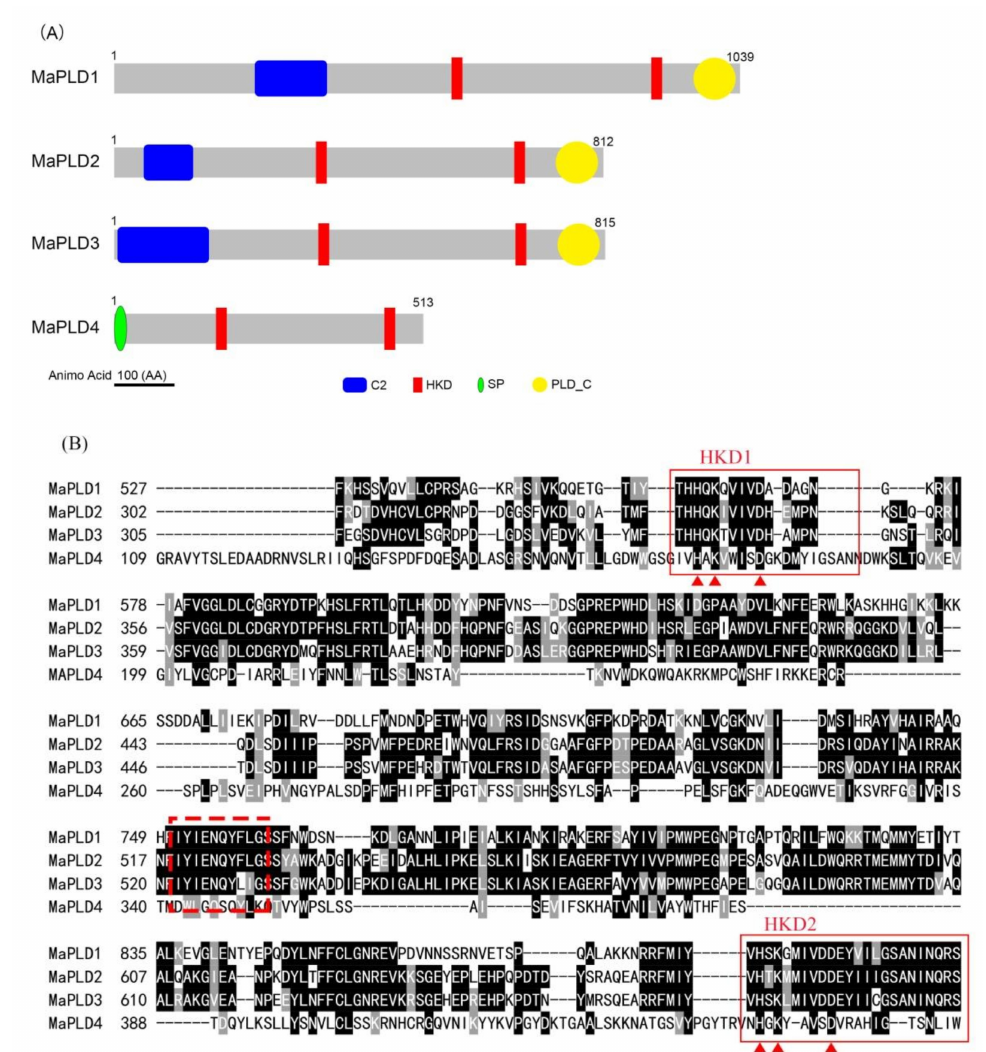
Figure 2. Schematic diagram for domain structures ( A ) and multiple sequence alignment ( B ) of four PLD genes in banana. The C2 domain (protein kinase C-conserved 2 domain), HKD domain, SP (signal peptide) and PLD_C (phospholipase D C terminal) domain are represented by several figures with different colors ( A ). Sequences of two HKD domains were aligned, and the conserved amino acids (His, Lys, and Asp) were marked by red triangles. The ‘IYIENQFF’ motif was marked by red dotted box ( B